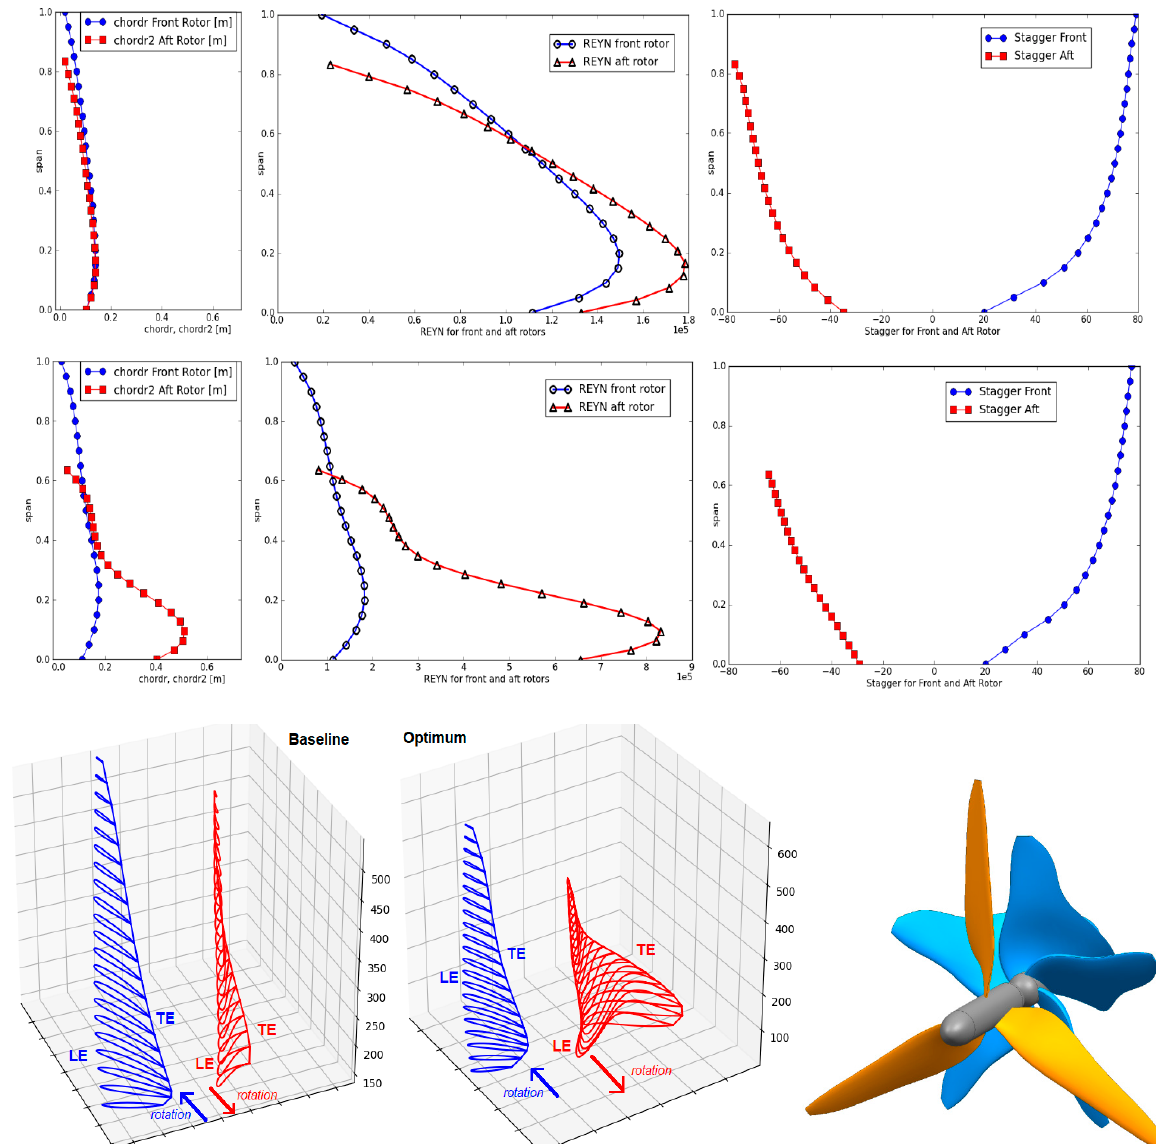
Figure 31. Spanwise chord, REYN, and stagger definition for baseline (top row) and optimal design (bottom row). The 3D blades are also compared, showing the direction of rotation.